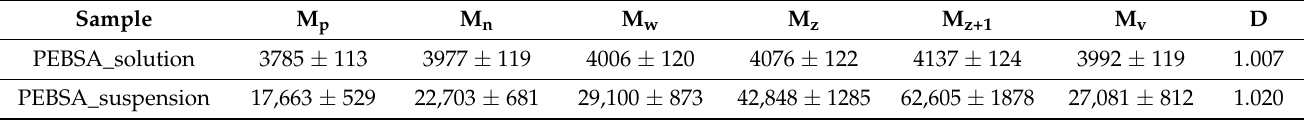
Table 1. Molecular weights of the synthesised